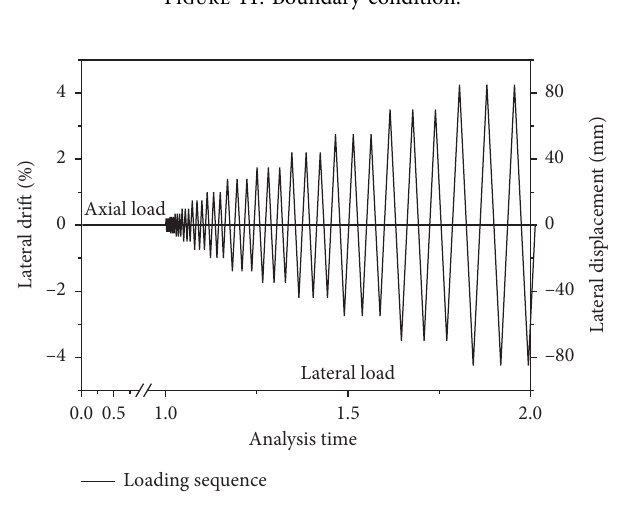
Figure 12: Loading sequence.